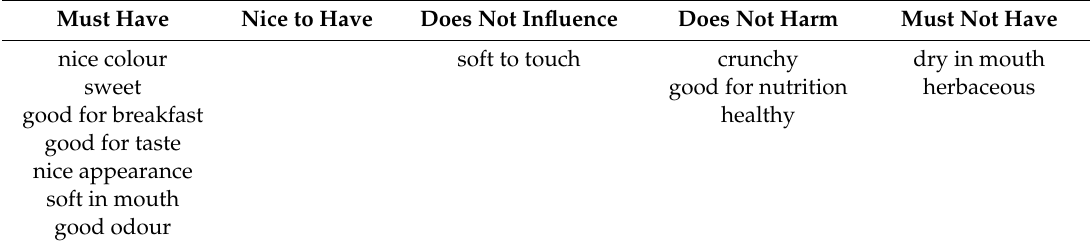
Table 5. Summary table of the penalty analysis results.